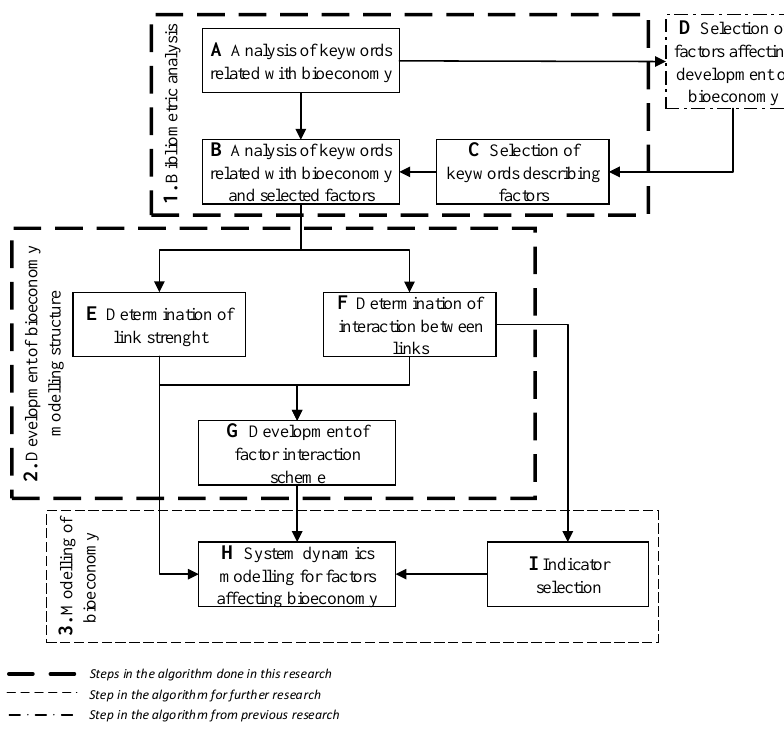
Fig. 1. Methodology